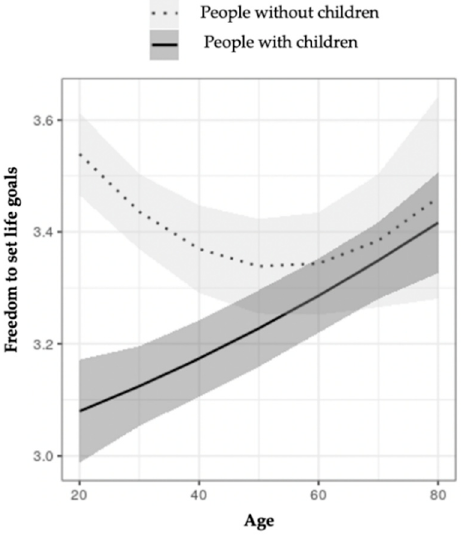
Figure 5. Moderation effect of age on the freedom to set life goals in people with and without chil- dren.